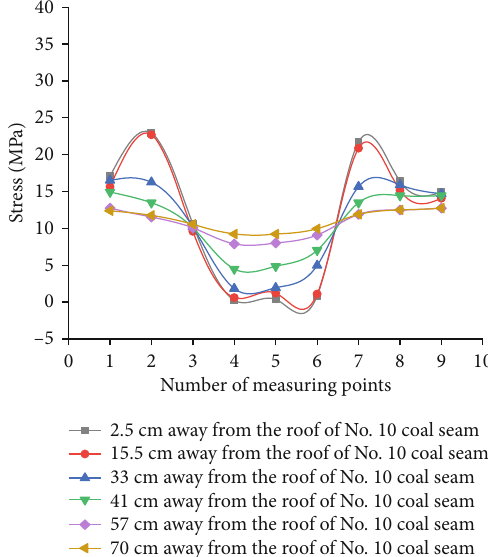
Figure 6: Stress diagram of working face mining at 55 m.